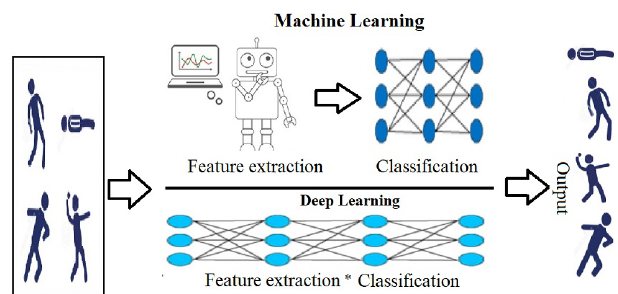
Fig 2. Machine learning algorithms were fed a set of relevant features for analysis, while deep learning algorithms worked with raw data and decided on their own the relevant